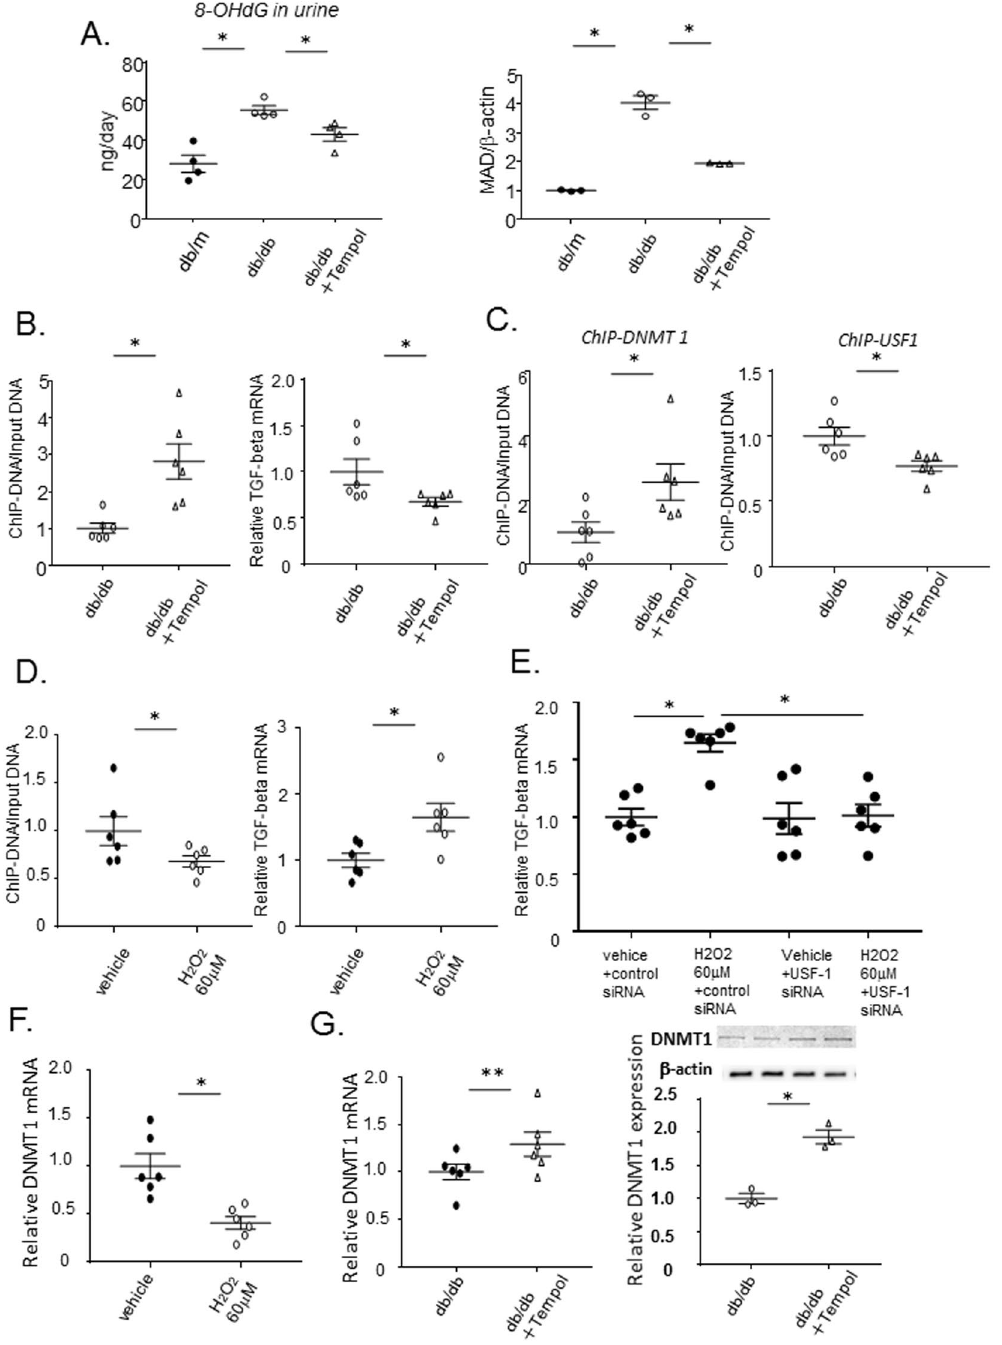
Figure 6. The effect of treatment with the anti-oxidant, Tempol to demethylauin of Tgfb1 in db/db mice and reactive oxygen species to methylation of Tgfb1 in mesangial cells. ( A ) Twenty-four hour urine samples were collected from db/m , db/db , and db/db mice treated with Tempol for 8 weeks in metabolic cages, and 8-OHdG was measured using a New 8-OHdG Check ELISA kit. Immunoblotting of MAD in whole kidneys of db/m , db/db , and db/db mice treated with Tempol for 8 weeks. Urinary 8-OHdG and renal MAD content were significantly increased in db/db mice compared with db/m mice, but treatment with Tempol significantly decreased these parameters. Beta-actin was used for normalization. Data represent the mean ± SEM. 8-OHdG, n = 4; MAD, n = 3. Filled circle: db/m mice; open circle: db/db mice; open triangle: db/db + Tempol. ( B ) DNA methylation and down-regulation of Tgfb1 in mesangial cells from db/db mice treated with Tempol. Quantitation of DNA methylation, using a MethylCollector Ultra kit, in mesangial cells from 15-week-old db/ db mice, treated or not treated with Tempol for 8 weeks. Quantitative real-time PCR of Tgfb1 and Gapdh mRNA from 15-week-old db/db mice treated or not treated with Tempol for 8 weeks. Tempol significantly increase DNA methylation and decreased Tgfb1 mRNA. Data represent the mean ± SEM. n = 6. ( C ) The results of ChIP assays to determine binding of DNMT1 and USF1 to the Tgfb1 promoter (TSS − 641 to − 636) in mesangial